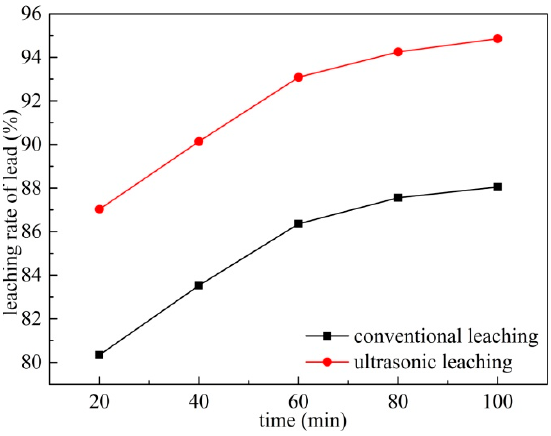
Figure 11. Effects of leaching time on leaching of Pb.